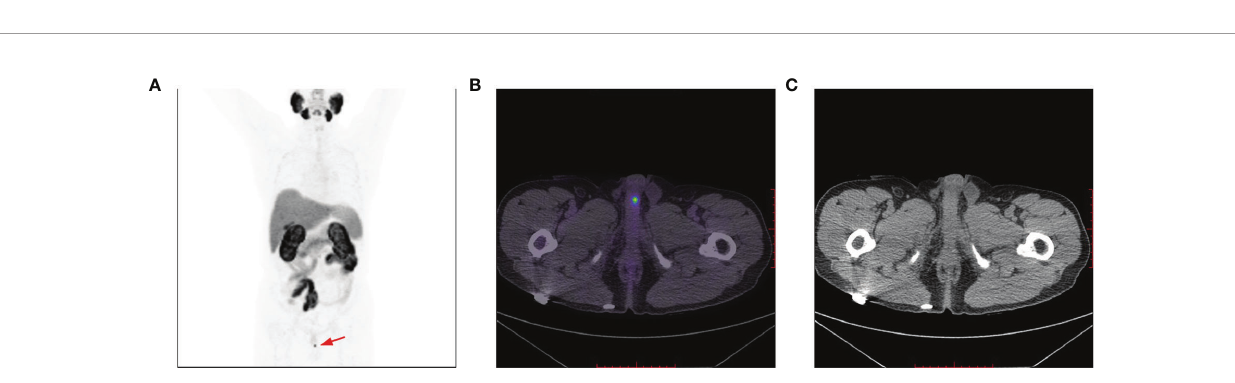
showed a marked increase in PSA value (>100 ng/ml), combined with penile bleeding. 18 F-PSMA-1007 PET/CT revealed that the uptake of penile lesions was signi fi cantly higher (SUV max 7.4) and that the range of lesions was enlarged than earlier; meanwhile,